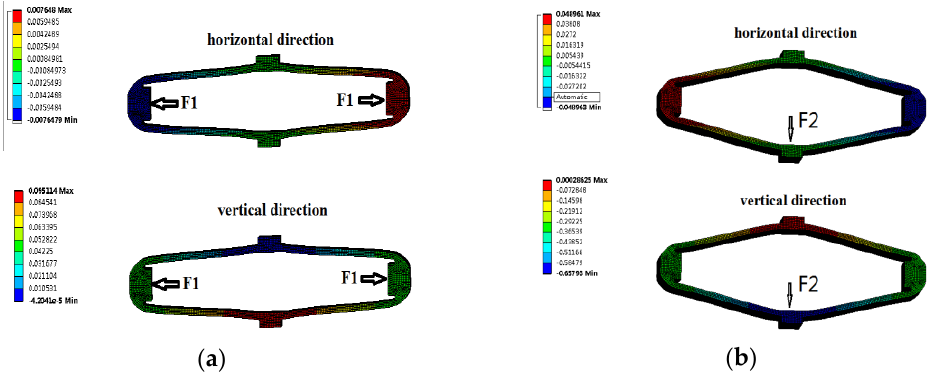
Figure 9. Diamond amplifier deformation: ( a ) Deformation under horizontal force; ( b ) Deformation under vertical force.